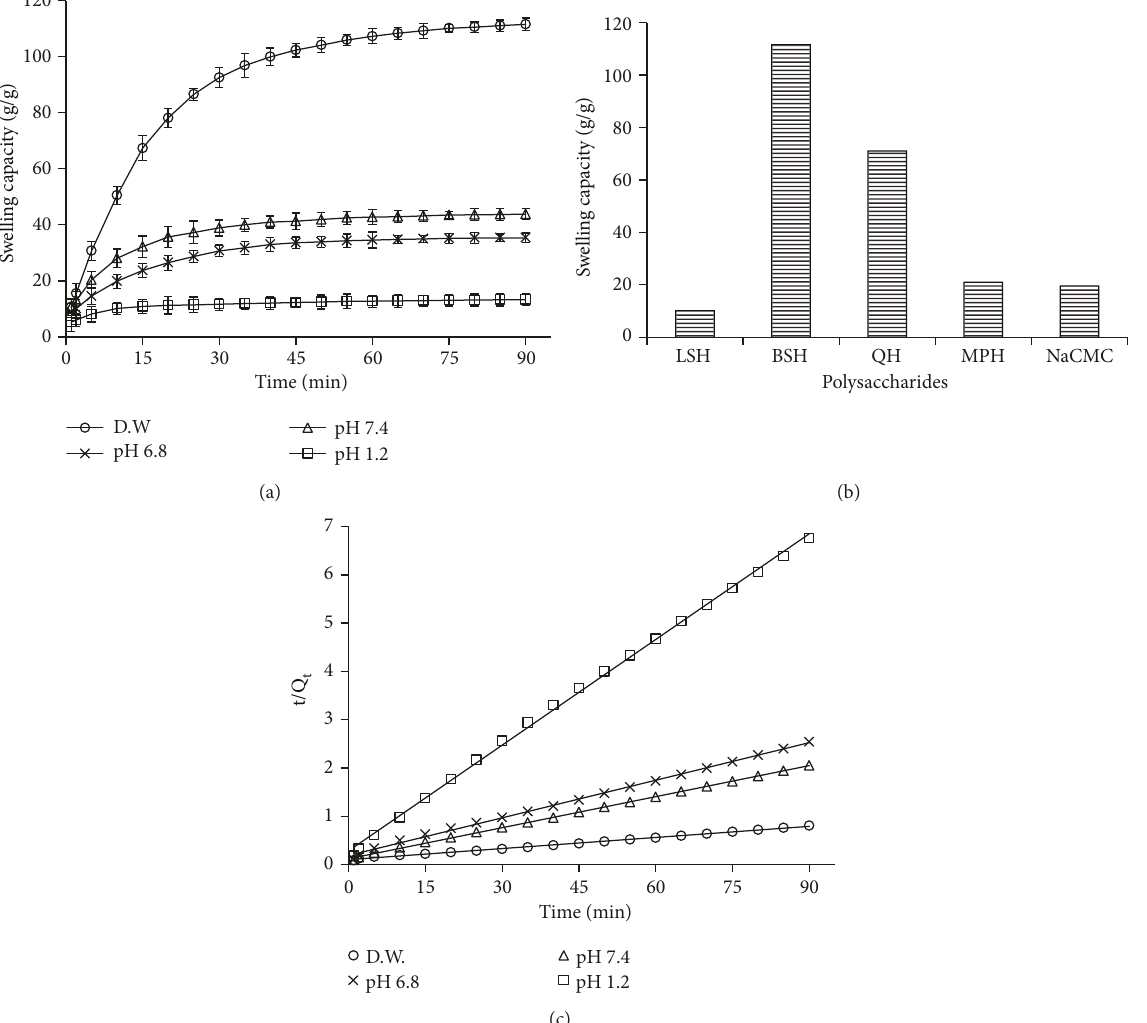
Figure 1: Swelling behavior in deionized water and different pH (a). Comparison of swelling capacity (g/g) of BSH with already reported polysaccharides LSH (Linseed hydrogel) [10], QH (Quince seed hydrogel) [4], MPH ( Mimosa pudica hydrogel) [3], and NaCMC (sodium carboxymethyl cellulose) [36] in the first 90 min (b). Second-order swelling kinetics of BSH in different media